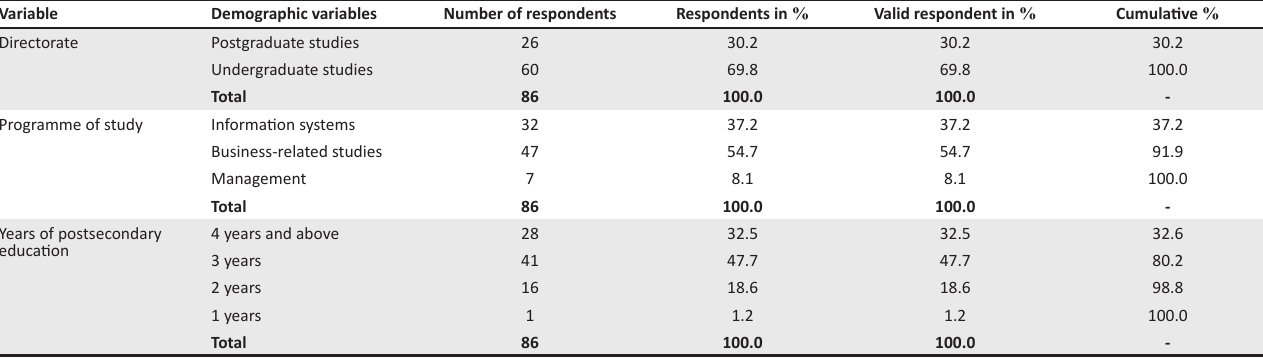
TABLE 2: Summary of demographic